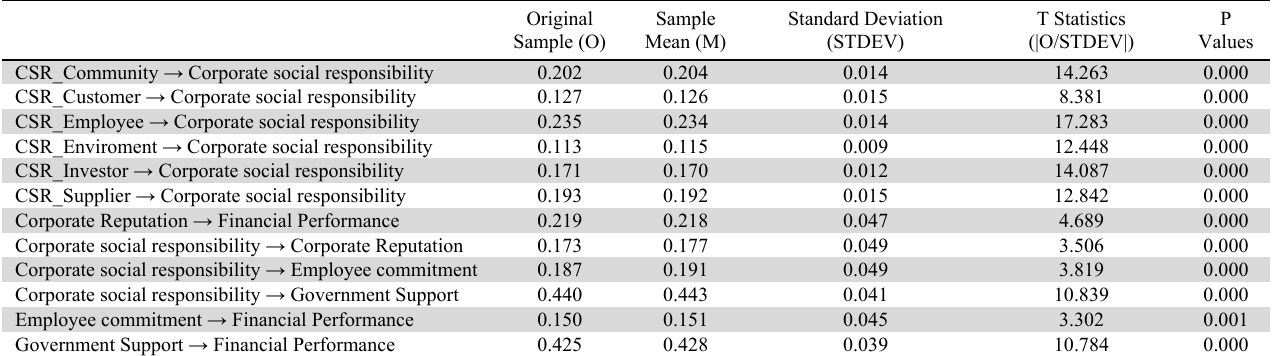
Original Sample Standard Deviation Sample (O) Mean (M) (STDEV)